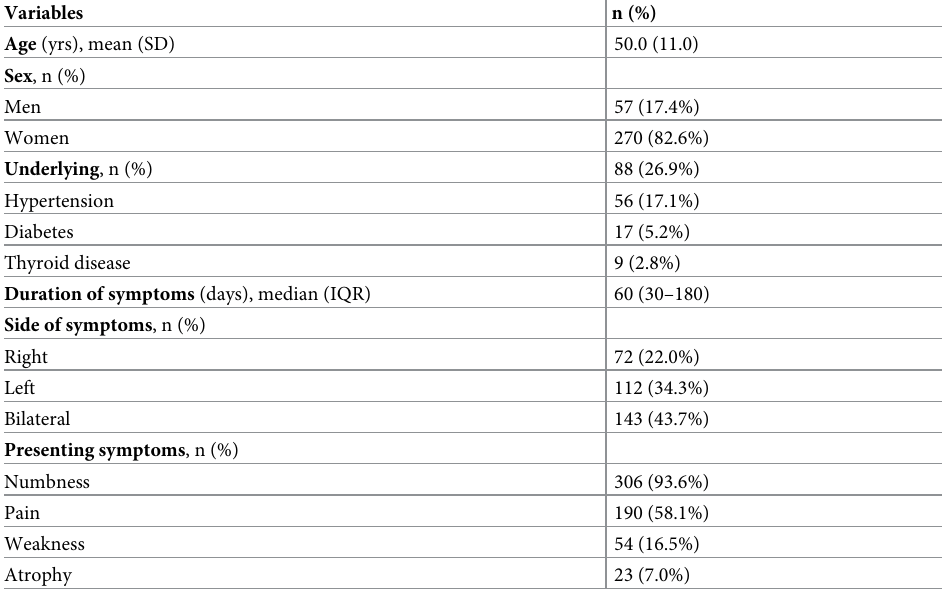
Table 1. Demographic data (n =